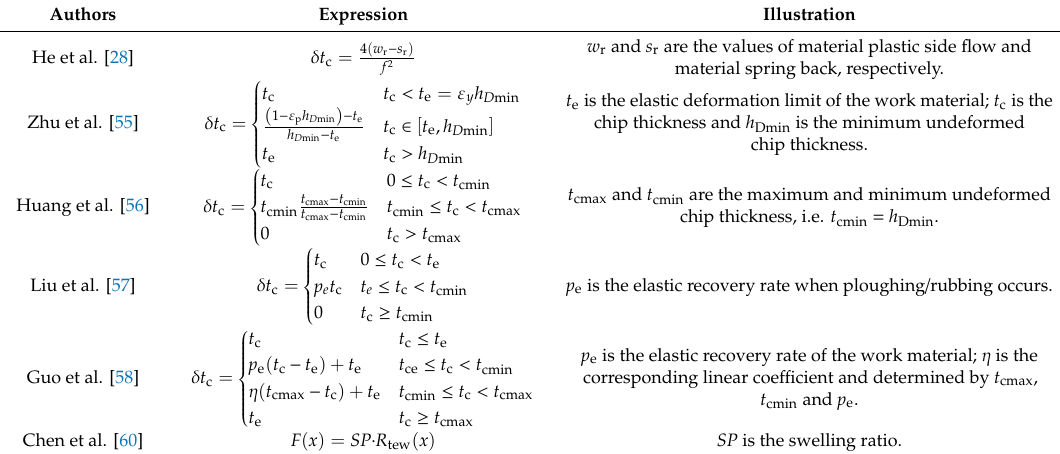
Table 1. The distribution model of material spring back and / or plastic side